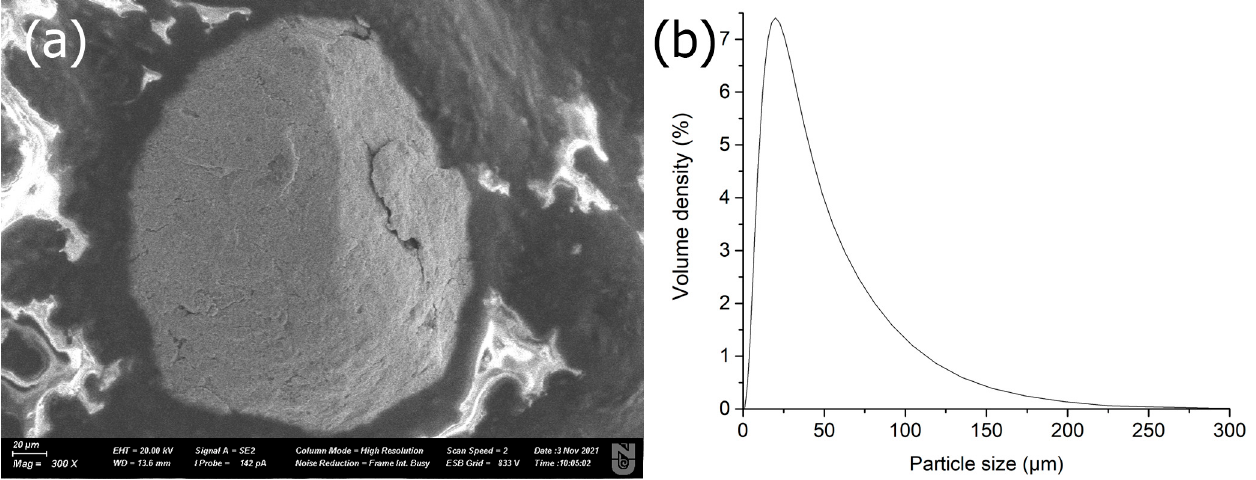
Figure 1. ( a ) SEM image and ( b ) particle size analysis of ZVI.